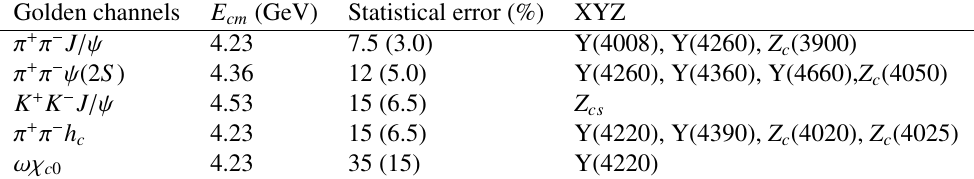
Table 1. Golden channels of the Charmonium in ISR physics program at Belle II. The predicted statistics erroros are given in percentage, assuming Belle II will run over 10 (50) ab − 1 integrated luminosity at the indicated energy in the center of mass values ( E cm ).